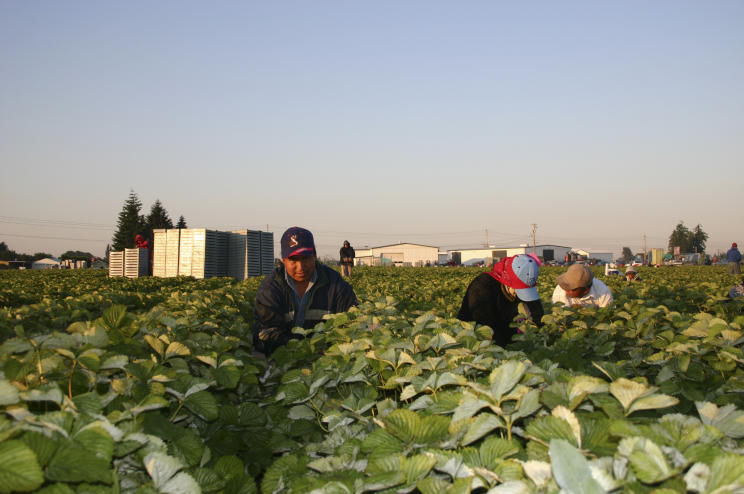
Triqui People Bent Over Picking Strawberries in Washington StateTriqui laborers picking strawberries on the Tanaka Farm in Washington state.